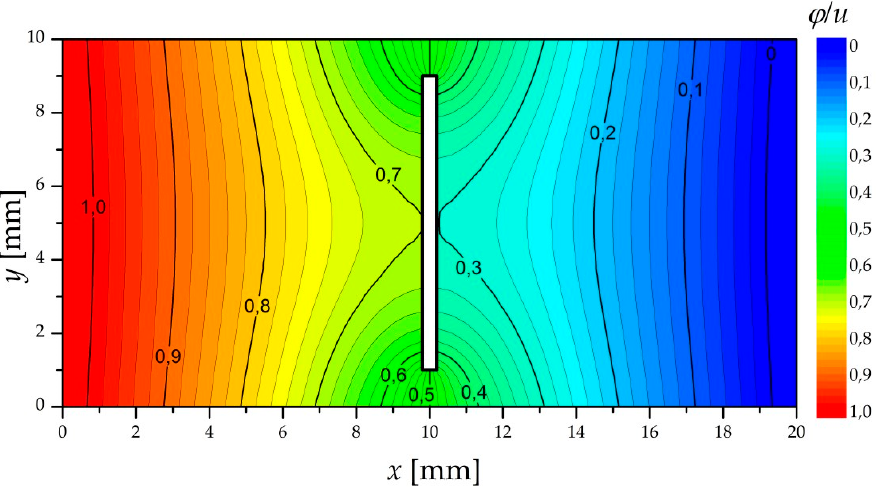
Figure 4. Potential distribution for an infinitely thin crack calculated on the basis of Formula (33) for E 0 = 5 V / m, θ = 90 ◦ , a = 8 mm.